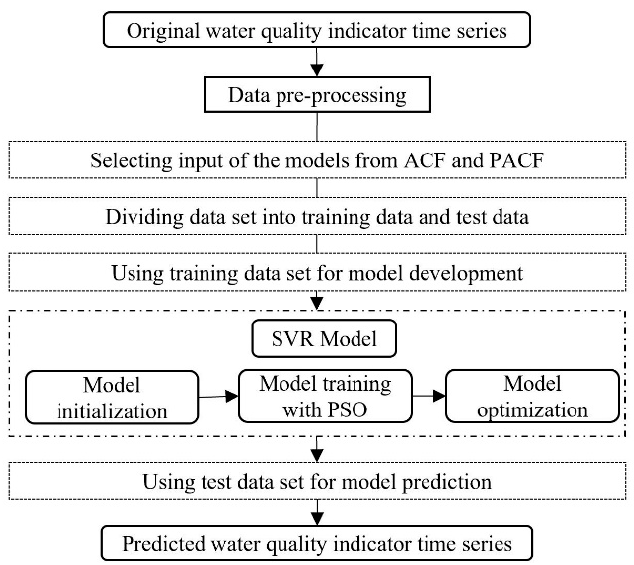
Figure A2. Flow chart of the PSO-SVR structure for the prediction of water quality indicators.